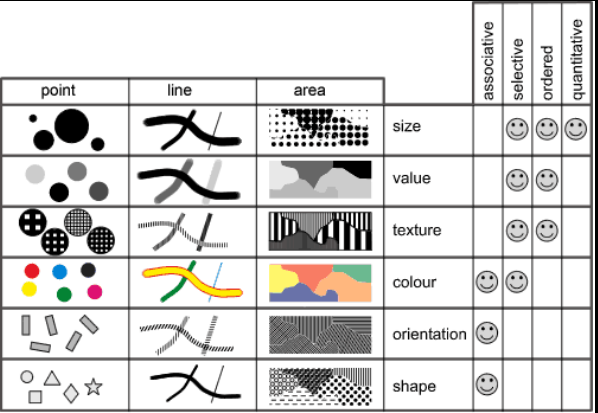
Fig. 2; J. Bertin's selection of visual